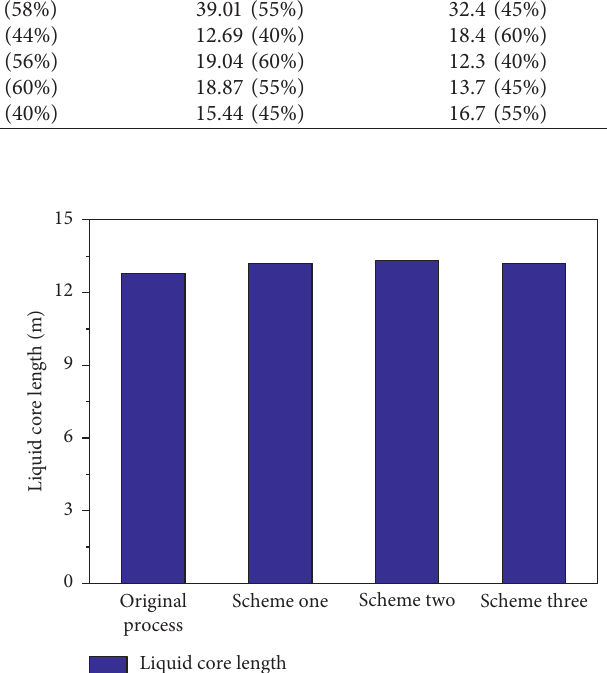
Figure 12: The curves of center temperature and slab shell growth under different water distribution schemes.